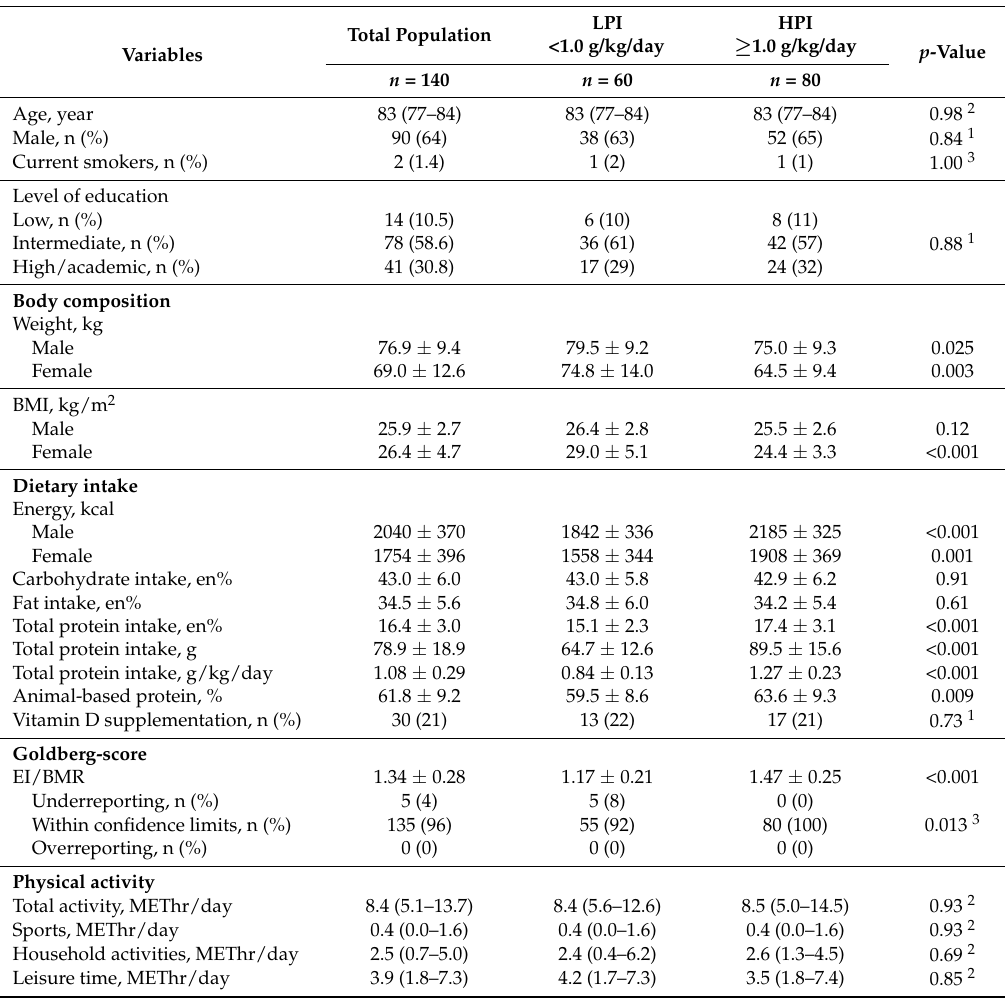
Table 1. Differences between groups based on cutoff value of 1.0